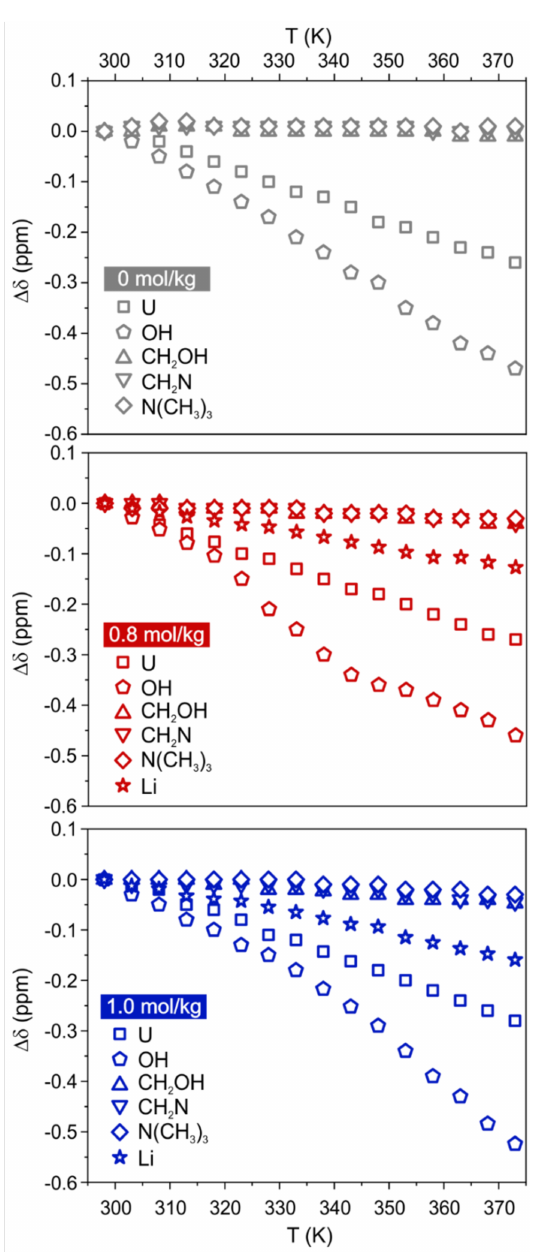
Figure 1. 1 H and 7 Li chemical shift variations of ChCl:U-LiCl(0) ( top , grey), ChCl:U-LiCl(0.8) ( middle , red), and ChCl:U-LiCl(1.0) ( bottom , blue), as a function of temperature. Maximum er- rors are estimated to be 2% for 1 H and 7 Li, and 4% for OH